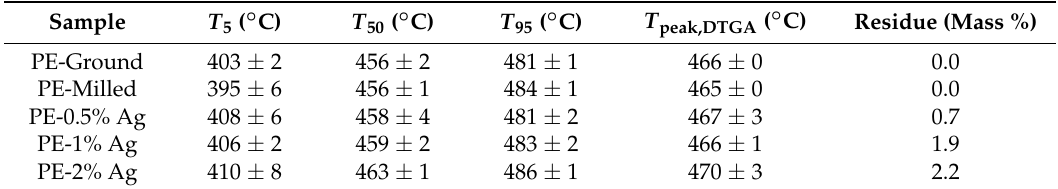
Table 2. Degradation temperatures obtained from TGA and DTGA curves and residual mass for